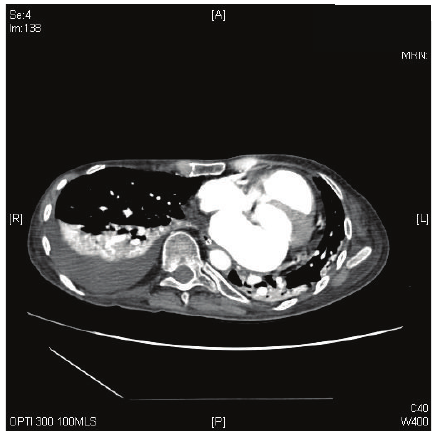
Figure 2: CT of urinary tract, performed on 24 July 2009, revealed multiple calculi in left kidney.